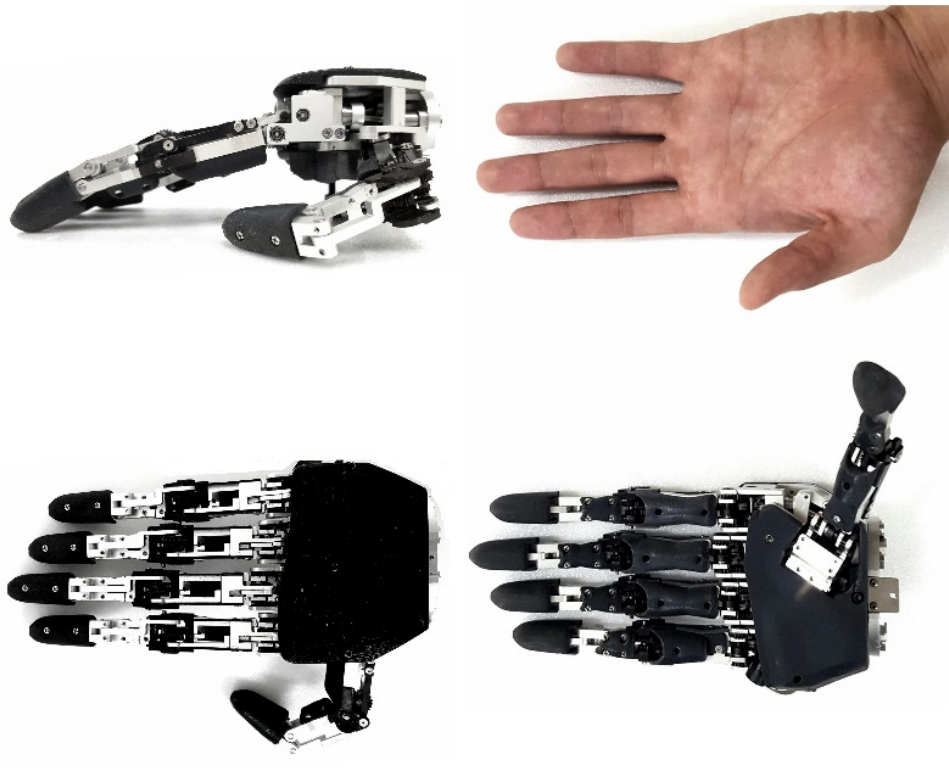
Figure 7. Prototype of the developed prosthetic hand and size comparison with a human hand. Table 2. Specifications of the developed prosthetic